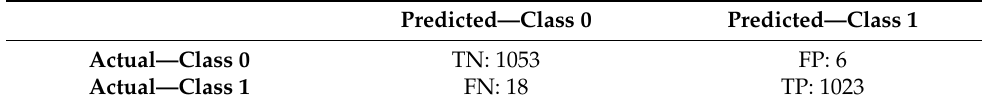
Table 4. Confusion Matrix for time series classification